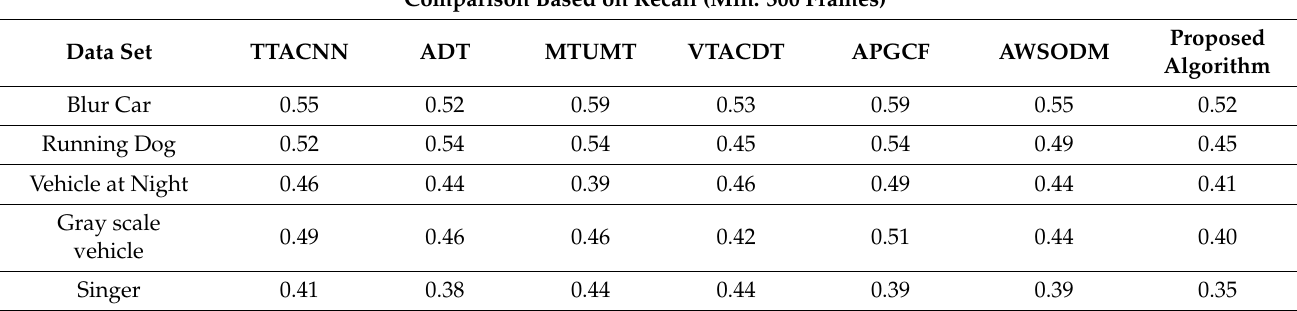
Table 5. Performance evaluation based on Recall. Comparison Based on Recall (Min. 300